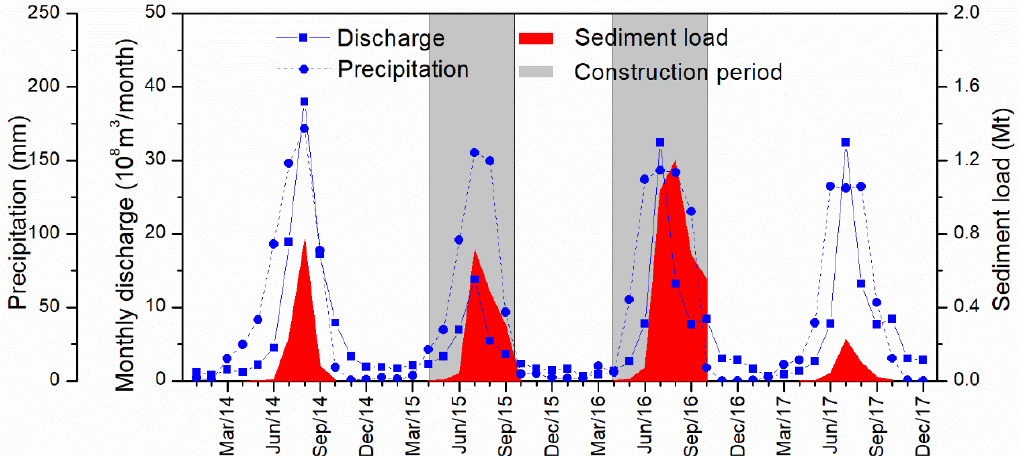
Figure 11. Monthly sediment load of the Lhasa Station combined with the monthly discharge and precipitation during precipitation during 2014–2017.